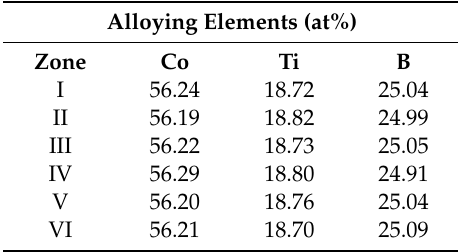
Figure 6. ( a ) FE-HRTEM, and ( b ) NBDP of (Co 75 Ti 25 ) 75 B 25 powders obtained after 50 h of MA time. The corresponding FE-SEM micrograph is shown in ( c ) together with the elemental EDS-mapping of ( d ) Co, ( e ) Ti, and ( f ) B. The circular symbols indexed with a Roman number (I, II, III, IV, V, and VI) in ( a ) refer to the zones selected for conducting local (~5nm in diameter) EDS elemental analysis. The analytical results are listed in Table 2. Table 2. FE-HRTEM / EDS elemental analysis of selected zones shown in Figure 6a.